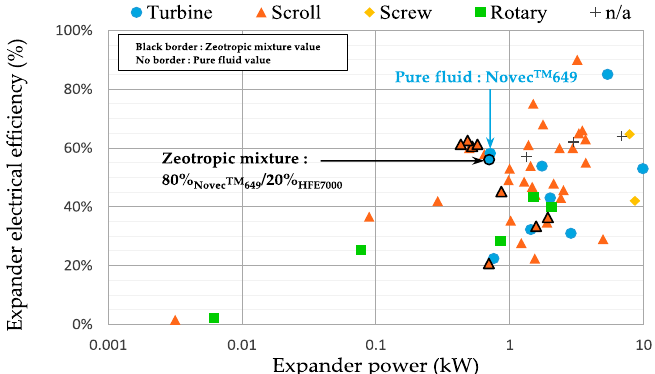
Figure 5. The expander electrical efficiency map for the Organic Rankine Cycle (ORC) up to 10 kW. 347